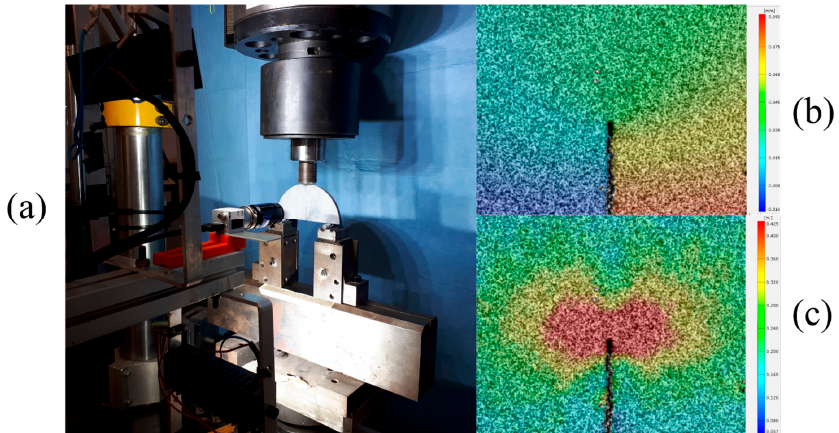
Figure 3. ( a ) Experimental setup; ( b ) crack axis normal displacement and ( c ) strain field correlated by the GOM software around the crack tip, for Mode I.